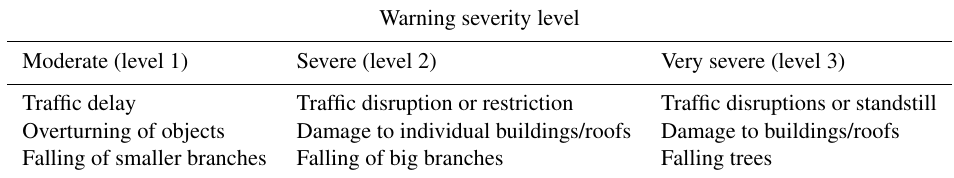
Table 2. Additional impact-based information per severity level in the impact-based warnings. Note that we did not observe any very severe (level 3) warnings during the data collection